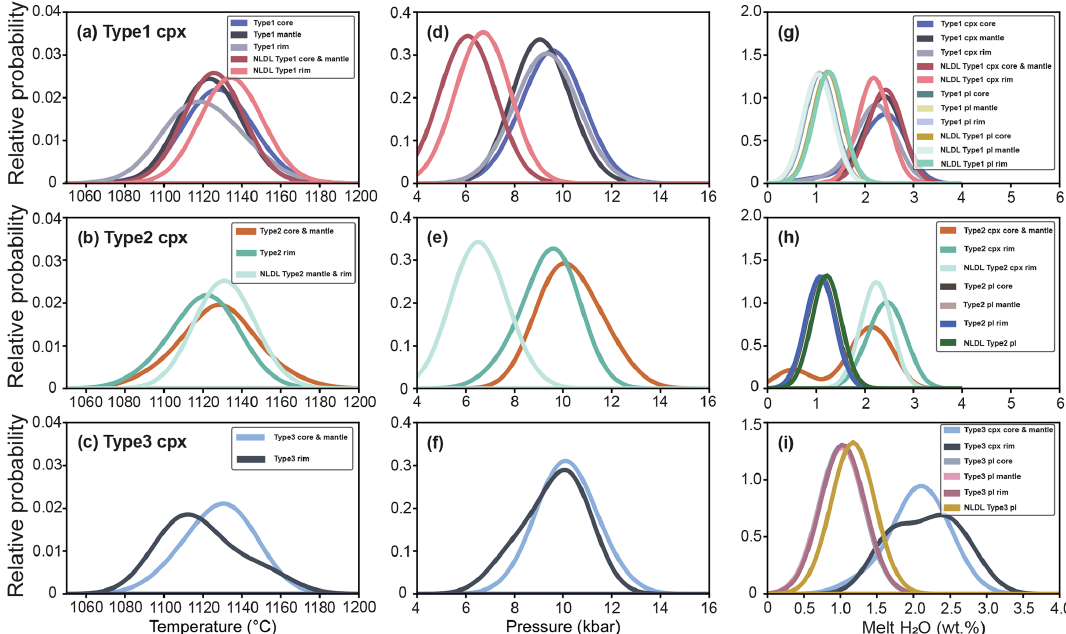
Figure 9. Kernel density estimates (KDEs) of thermobarometric and hygrometric calculation results for the Type 1 (a, d, g) , Type 2 (b, e, h) and Type 3 (c, f, i) of clinopyroxene and plagioclase (g, h, i) in the WVF. Crystallization temperatures and pressures are calculated following the clinopyroxene–melt thermobarometer of Neave and Putirka (2017). The melt water contents are following the clinopyroxene–